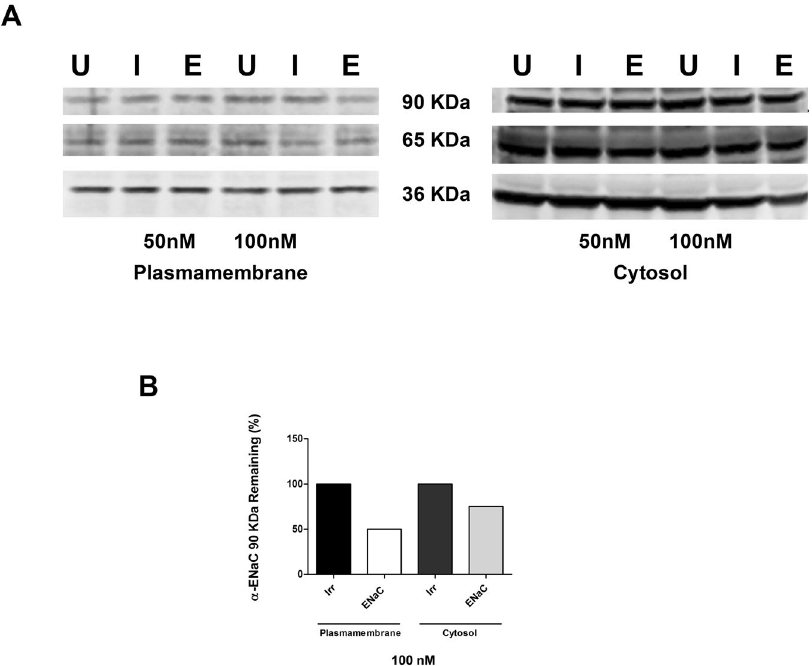
Figure 6. Western blotting of α -ENaC protein from A549 cells transfected with peptide E-LPRs. ( A ) Representative western blotting showing the α -ENaC major forms of 90 KDa and 65 KDa bands protein levels after treatment with LPR at both 50 nM and 100 nM siRNA, and GAPDH (36 KDa band). The lanes are indicated as following: untransfected control (U), treated with non-targeting/irrelevant siRNA (I) and α -ENaC siRNA-treated (E). ( B ) The densitometry results of 90 KDa α -ENaC protein from siRNA-treated cells extracted from the plasma membrane and from the cytosolic fraction, and expressed as percentage relative to the non- targeting/irrelevant siRNA-treated at a concentration of siRNA of 100 nM, showed that 50% of the subunit was still present at the cell surface, while 75% was still present in the